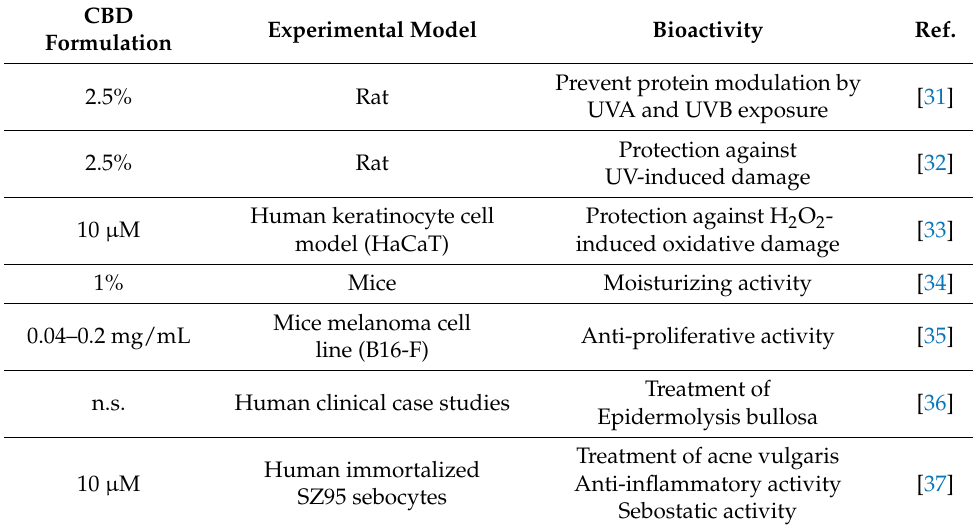
Table 1. Health-promoting bioactivities of CBD at skin